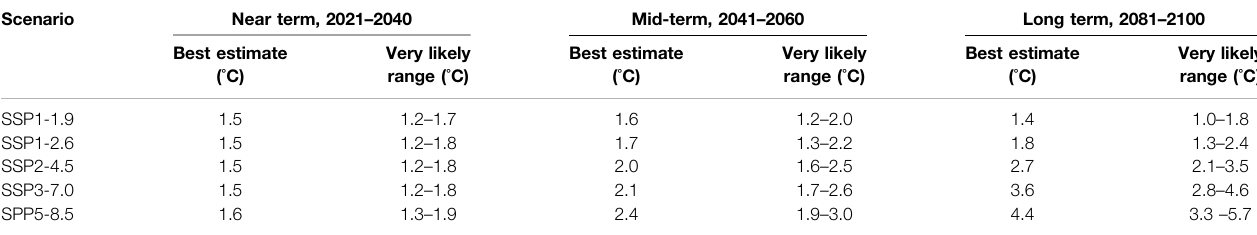
TABLE 1 | The climate scenarios in the Sixth Assessment Report of IPCC. Scenario